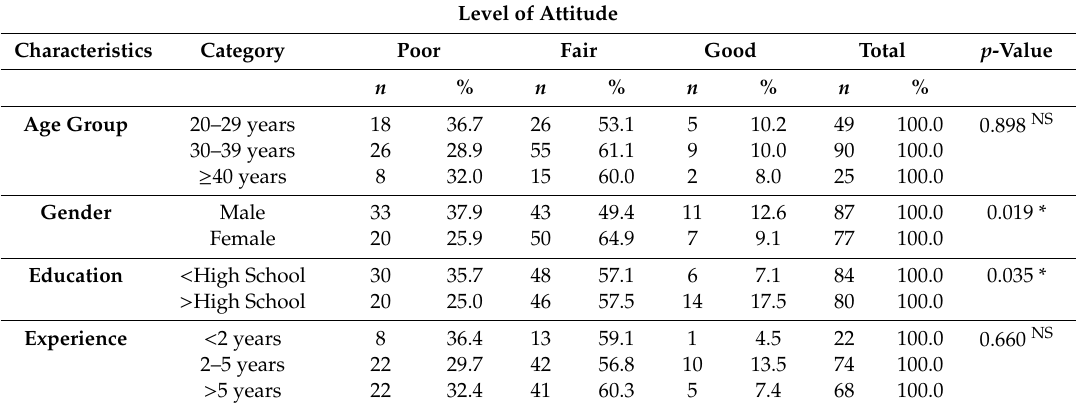
Table3. Distributionofthelevelsofattitudeaccordingtothedemographiccharacteristicsofrespondents. Level of Attitude Characteristics